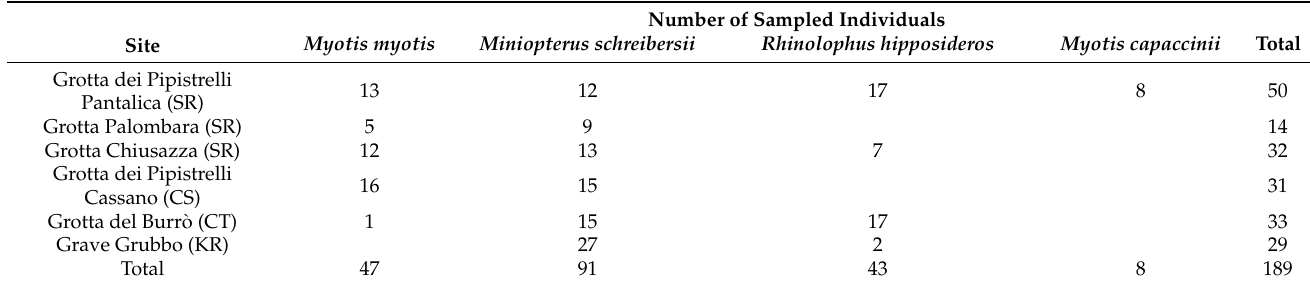
Table 2. Number of sampled individuals in the six study areas by